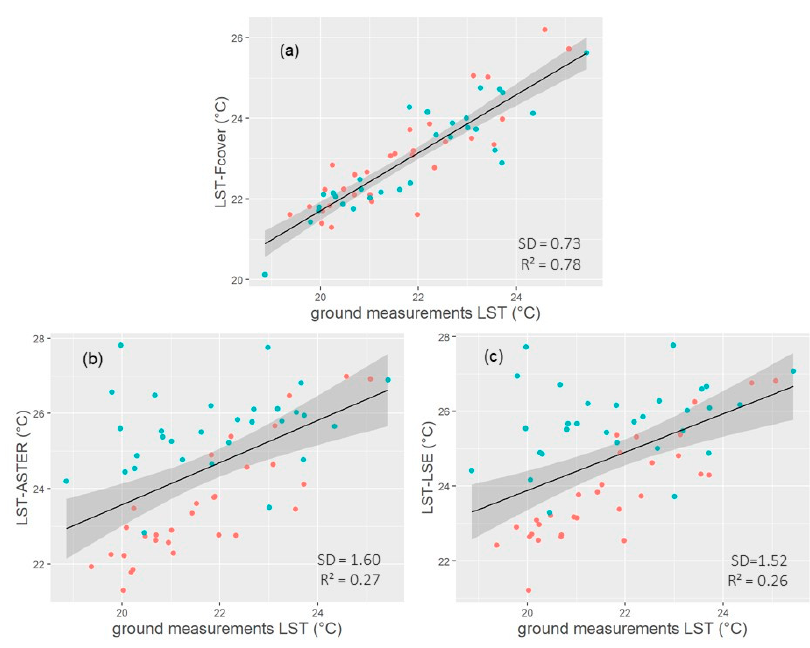
Figure 8. Regression analysis between LST from L8OLI/TIRS and that from ground measurements. Color code: Orange, January; Green, September ( a ) F cover ; ( b ) ASTER-GEDv3; ( c ) LSE model.